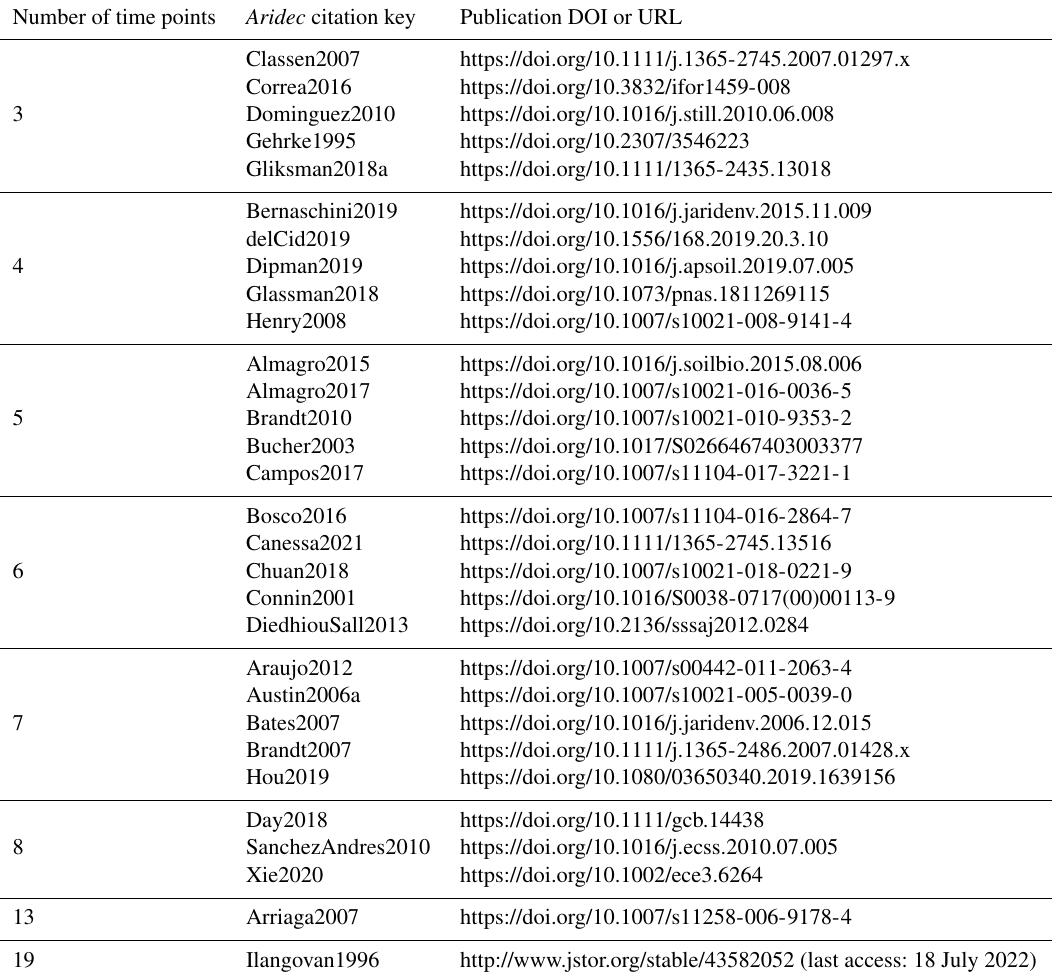
Table 2. Aridec entries used in the identifiability analysis with their corresponding DOI o URL. The number of time points refers to the number of sampling dates at each study plus the initial date.